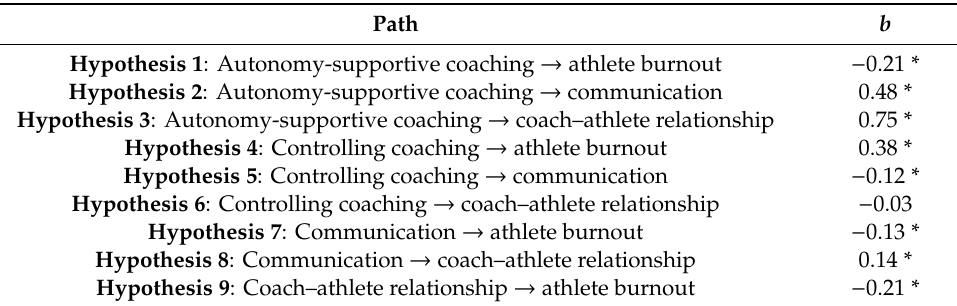
Table 4. Path coe ffi cients between Latent Variables.